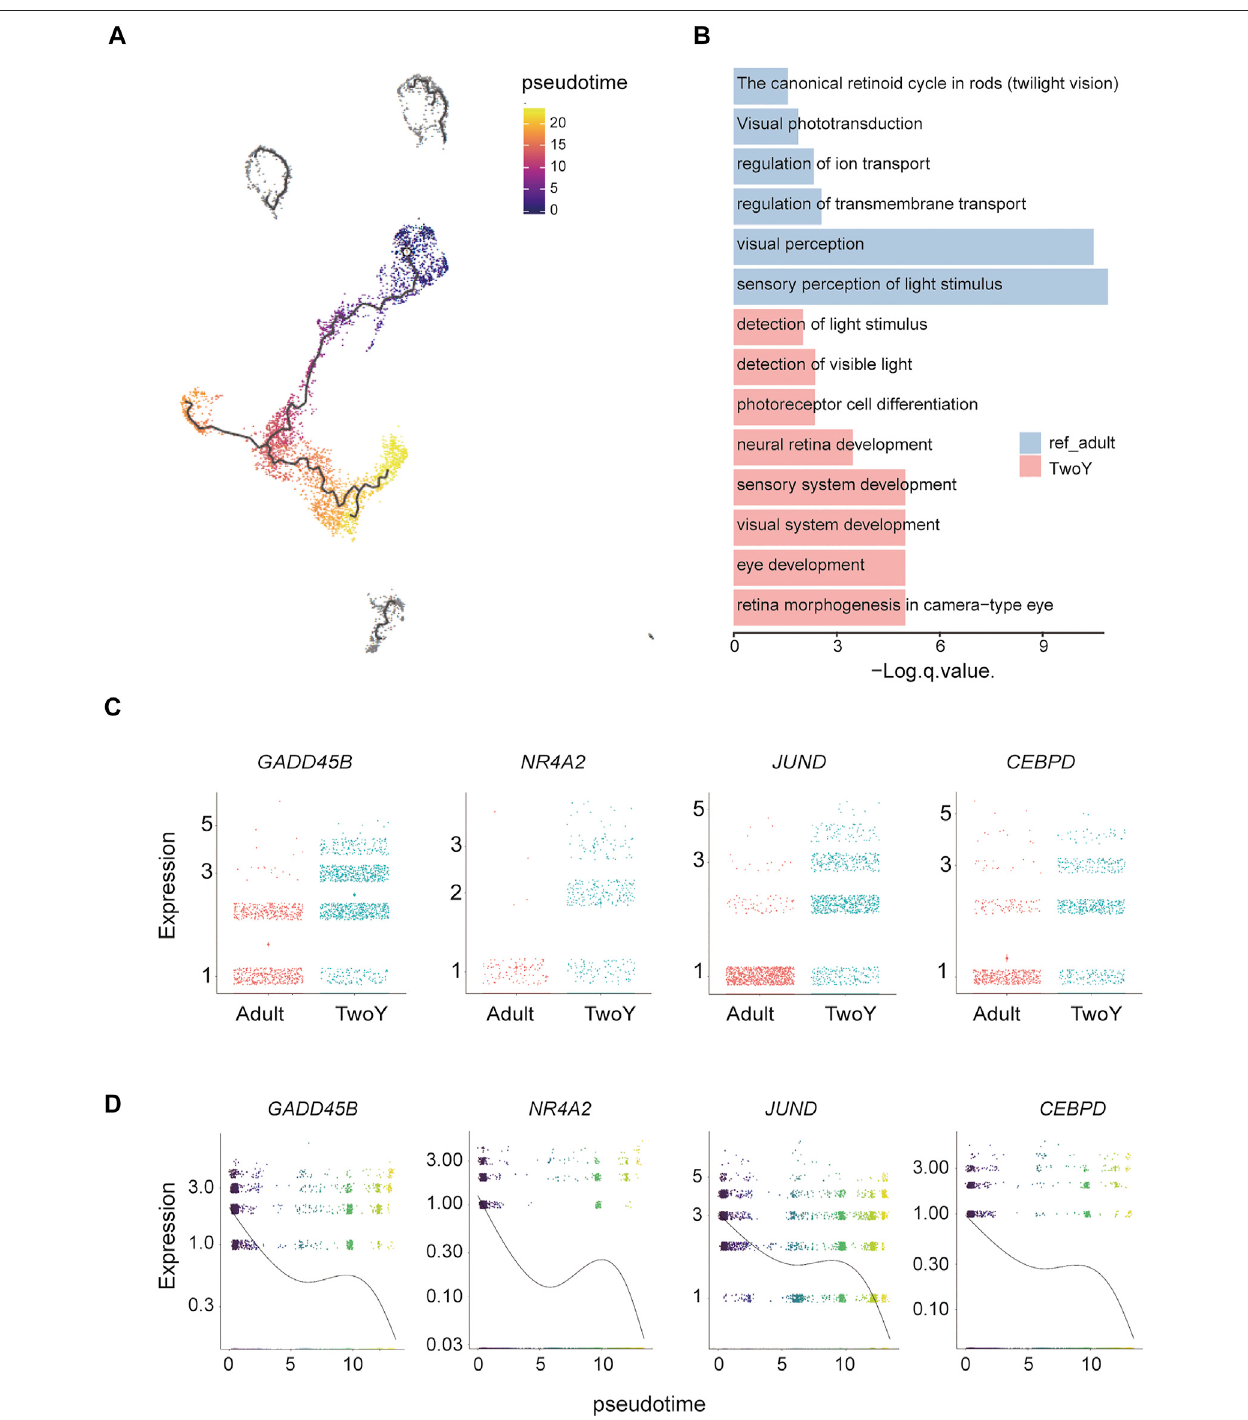
FIGURE 5 | Trajectory analysis and comparison with reference adult data of MGs. (A) Cell lineage relationships of reference of adult cells and MGs. Monocle recovers a branched single-cell trajectory. Each dot represents a single cell. The dark colors are the starting point of the trajectory, which represent the cells in early development stage, mainly derived from TwoY MGs; the light colors represent the end of the trajectory, which represent late developmental cells, mainly derived from adult MGs. Thedark gray clusters(top part oftheUMAP map)arecell populations that donot conform tothedevelopmentaltrajectory. (B) The enriched GOterms show the different cellular properties of the MGs in adults and young children. (C) Comparison of reference data from the MGs populations of adults and young children by differential gene expression. (D) Illustration of the decrease in related genes during evolution in a pseudotime analysis by Monocle.